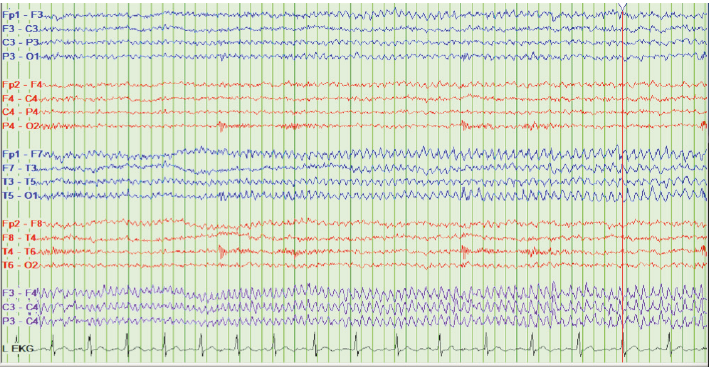
Figure 2: Electroclinical seizure: rhythmic theta discharges originating from left frontocentral/ frontotemporal region.